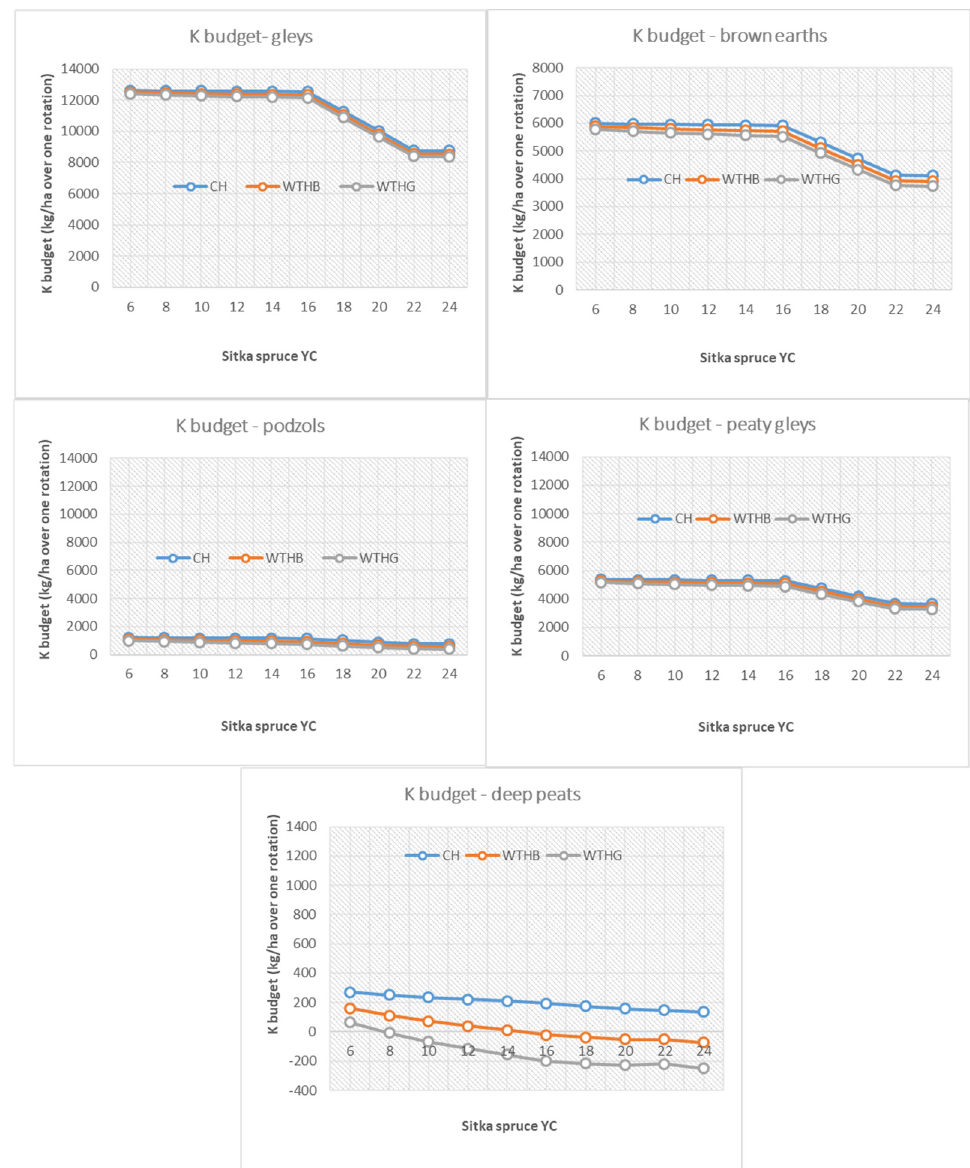
Figure 7. Forest K budget for Sitka spruce first rotation, YC 6-24, on five main forest soil types.